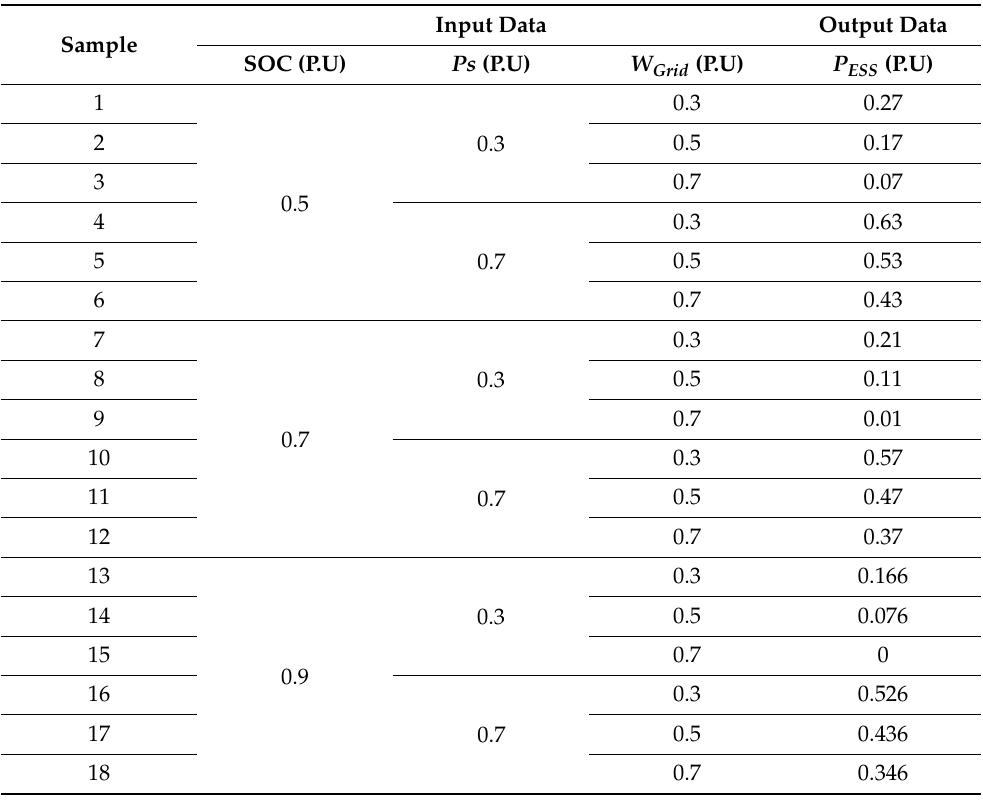
Table 2. ANN training data of mode